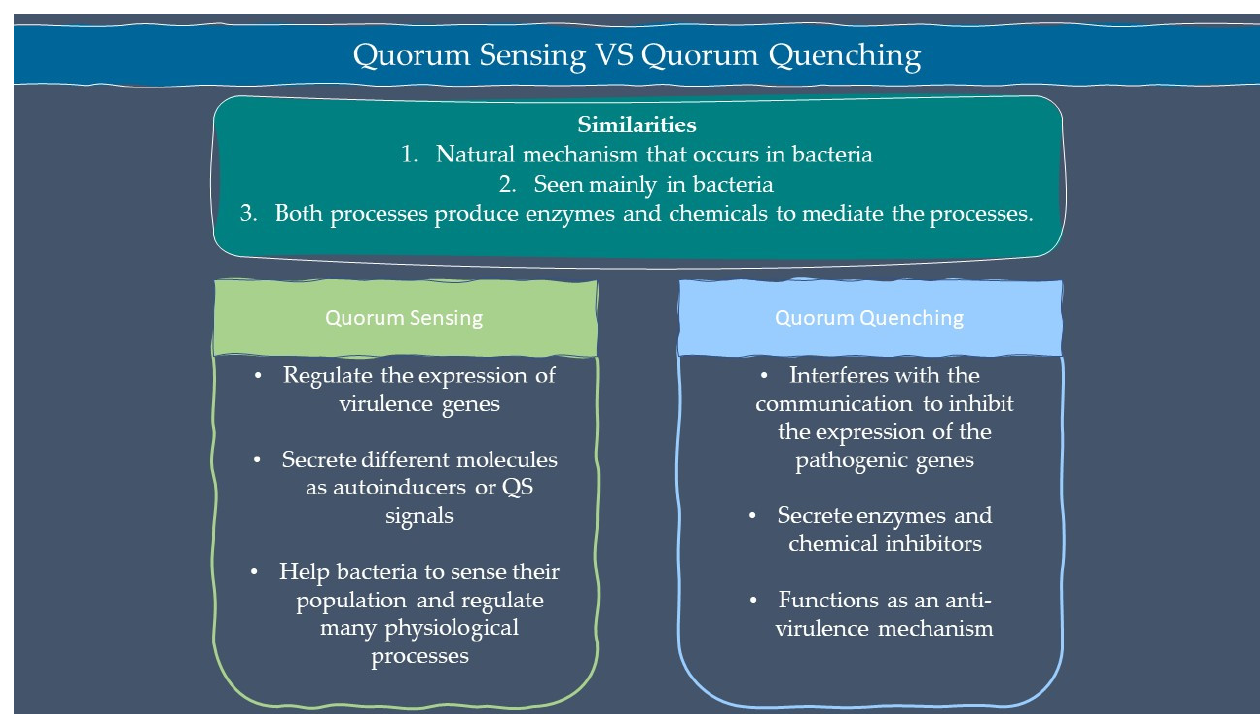
Figure 1. Summary of quorum sensing and quorum quenching.